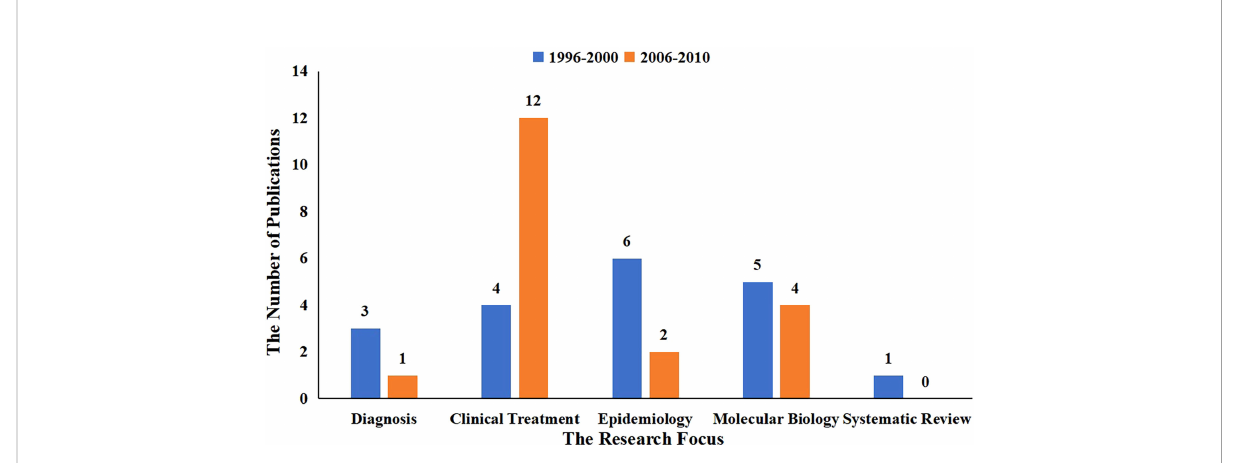
FIGURE 2 The research focus of papers published between 1996 and 2000 and between 2006 and